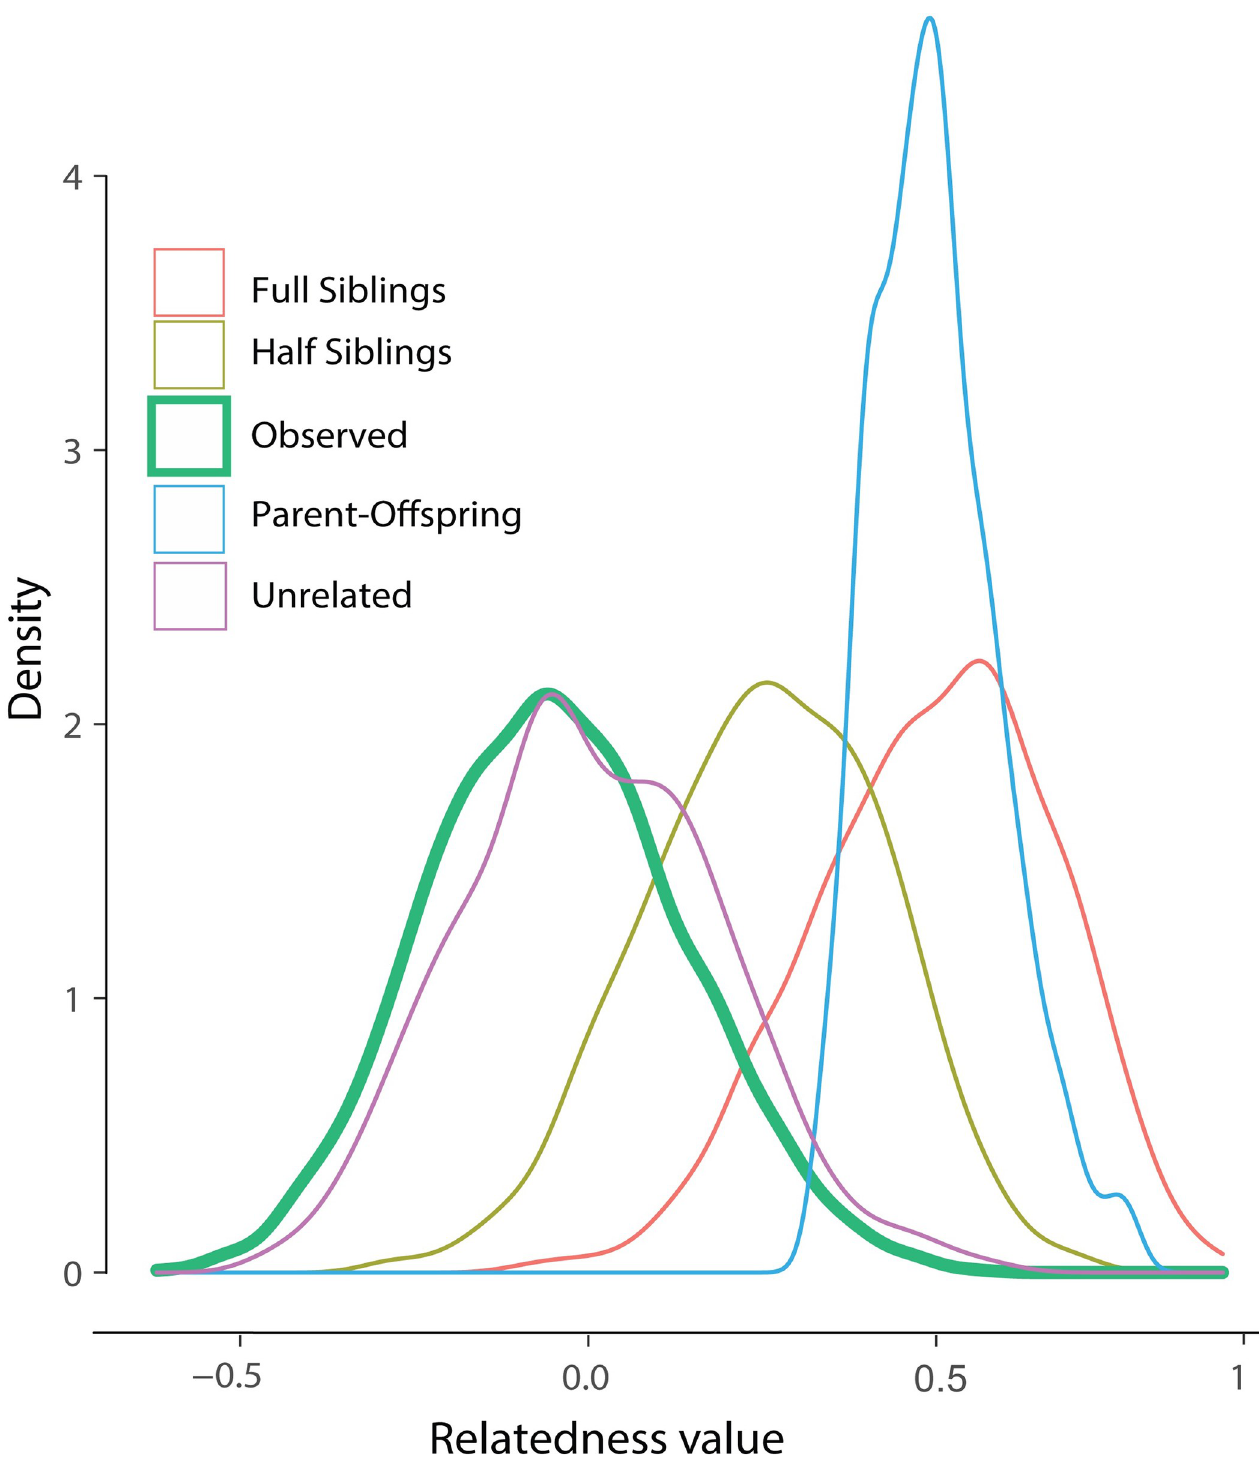
Fig 3. Distribution of pairwise genetic relatedness. Distribution of pairwise genetic relatedness values for simulated pairs of individuals: Full siblings (FS), Half siblings (HS), Parent/Offspring (PO), and for observed pairs of individuals of Sphyrna lewini sampled in coastal areas of the ETP.